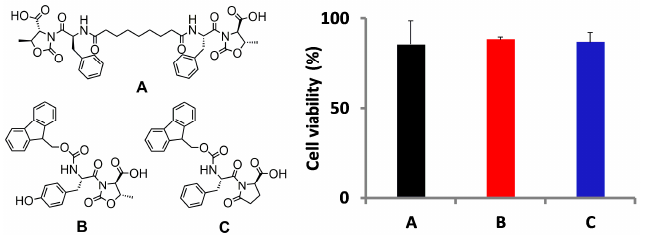
Figure 12. ( Left ) chemical structure of the gelators A–C, studied in this work. ( Right ) viability of embedded HGFs in hydrogels A, B, and C after seven days of culture. Data were expressed as relative percentage ± SD compared to control HGFs. Image adapted with permission from reference [59].